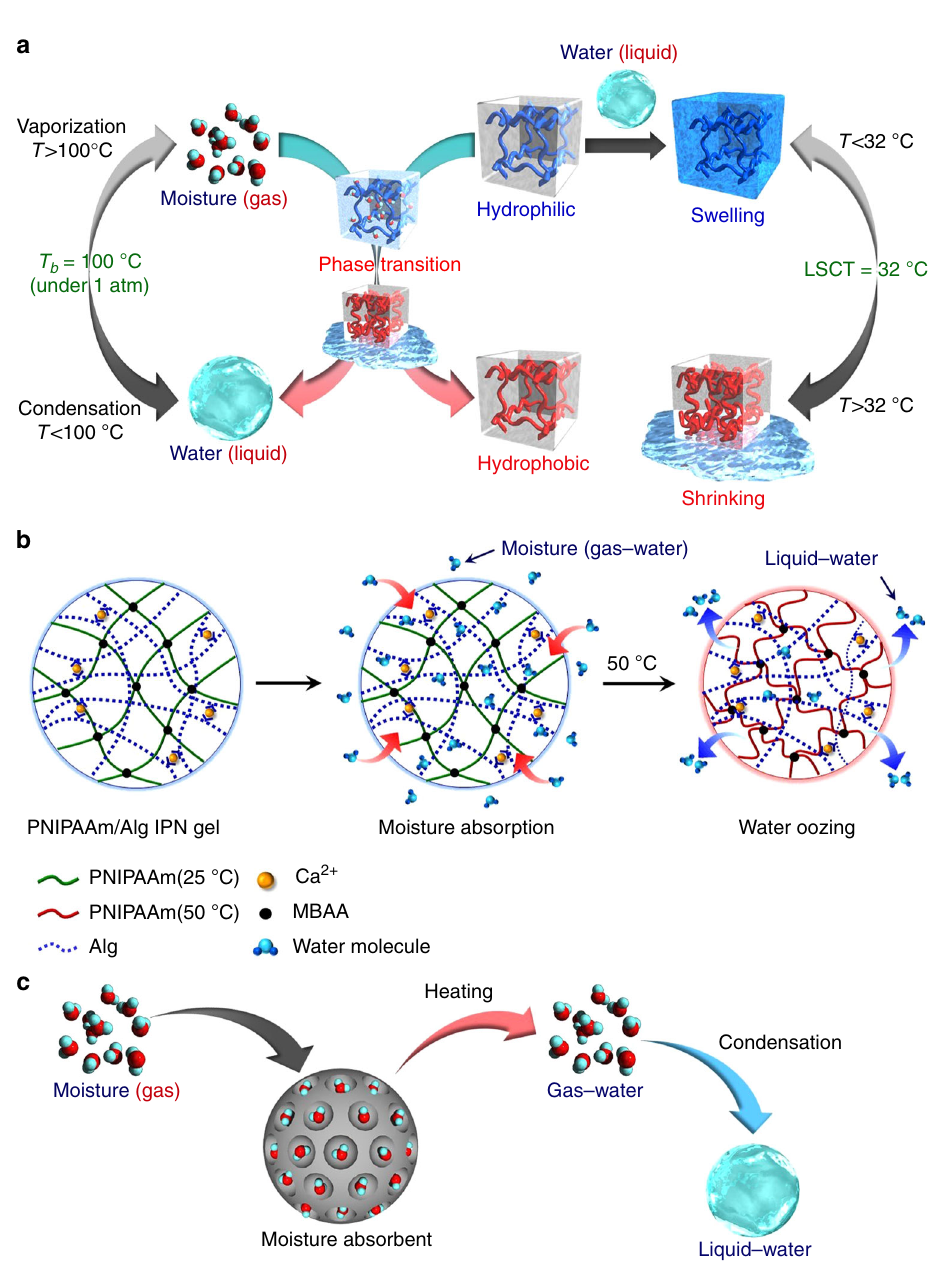
Fig. 1 Conceptual illustration of this study. a Water-adsorption and oozing behavior of dried PNIPAAm/Alg IPN gel. b Moisture absorption and oozing behavior of IPN gels caused by temperature changes. c Condensation of moisture using a standard